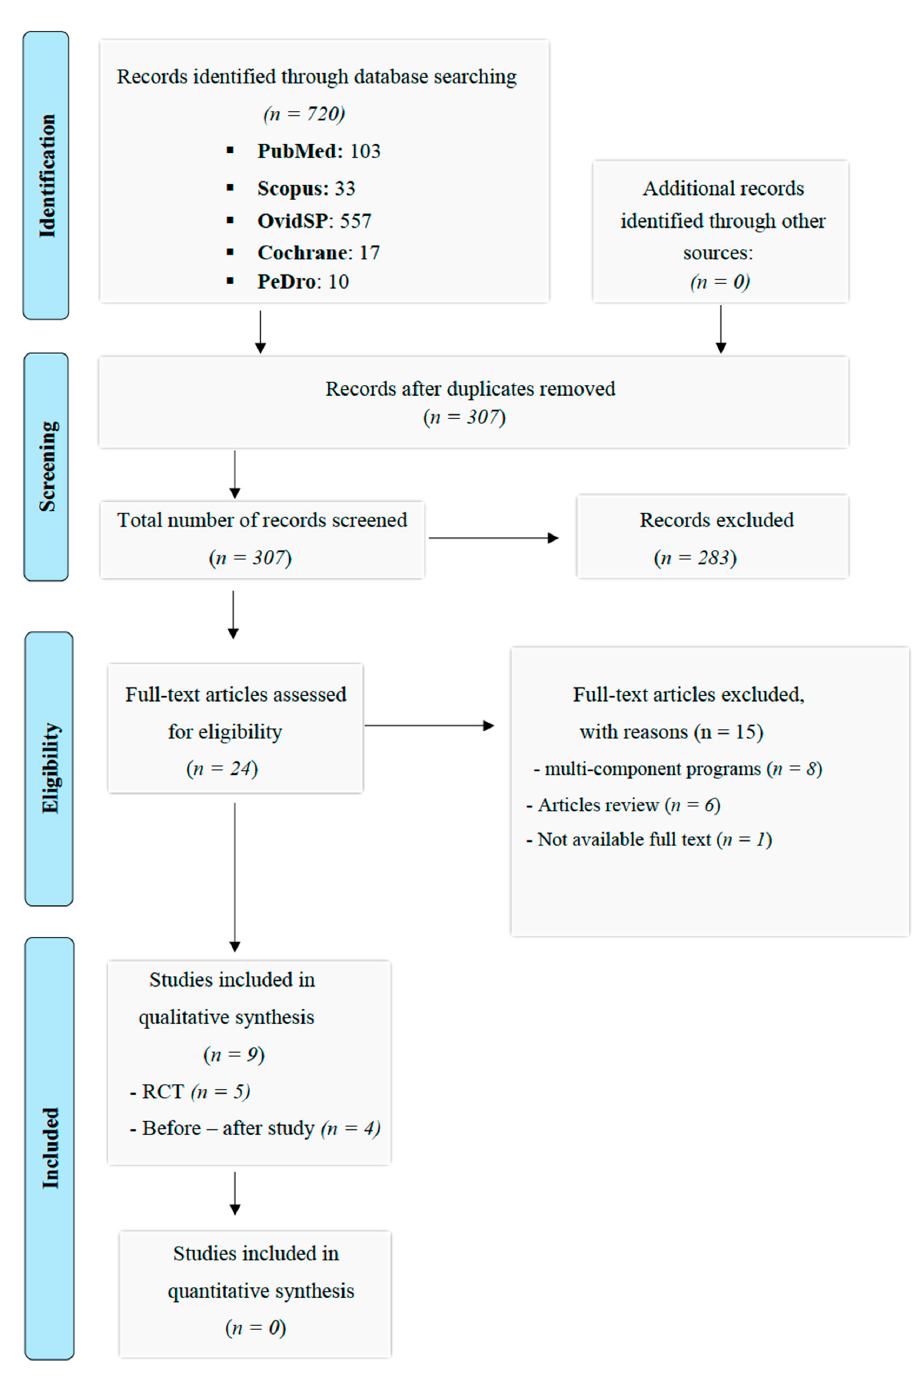
Figure 1. Flow diagram.